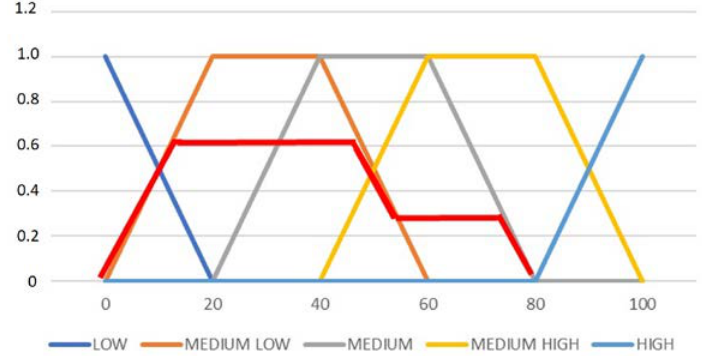
Figure 16. Aggregation of rules for design for machining technology